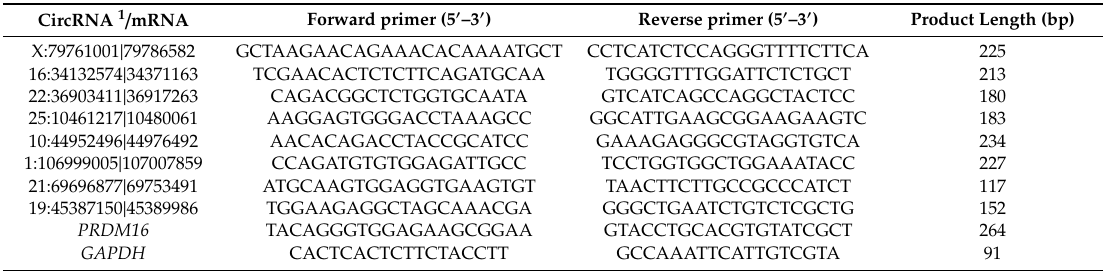
Table 1. Primers used for the validation of di ff erentially expressed circular RNAs (circRNAs) and circRNA–mRNA